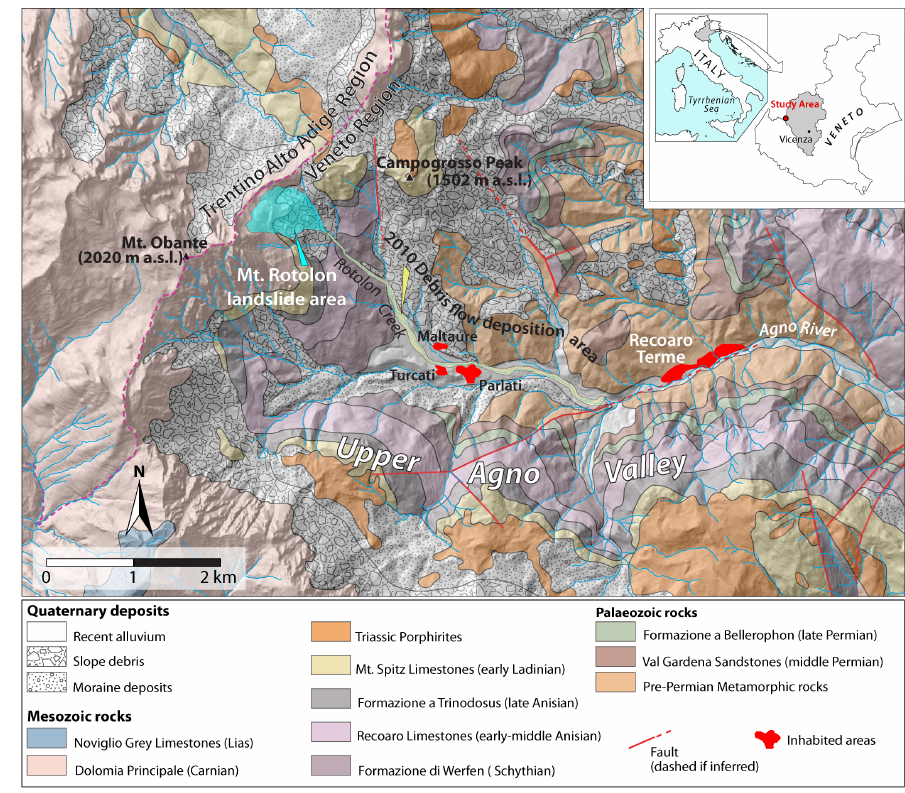
Figure 1. Geological sketch map of the upper Agno River valley with the location of the Rotolon